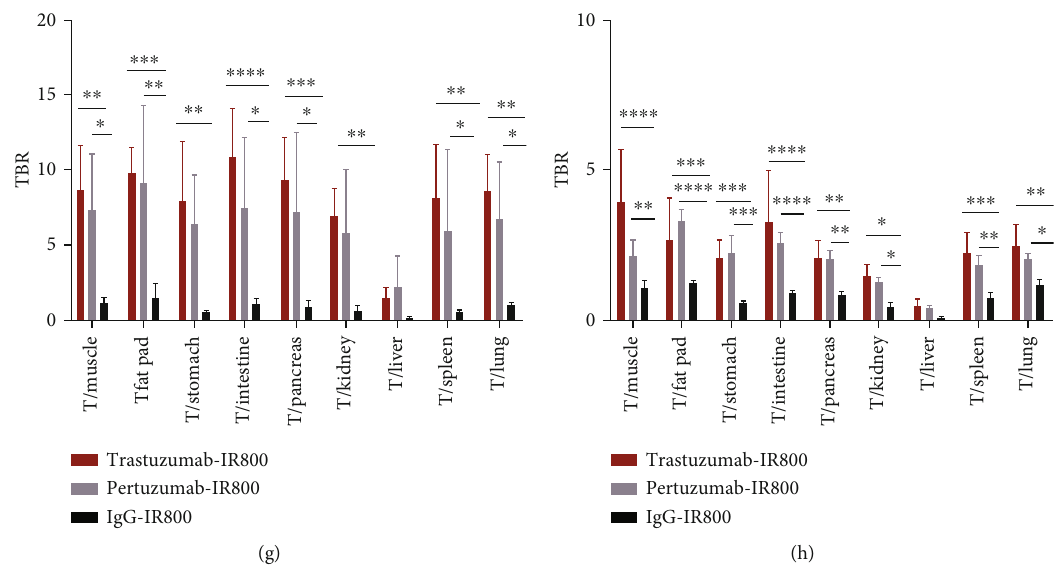
Figure 4: In vivo imaging of fl uorescently-labeled trastuzumab and pertuzumab in mouse xenografts. Representative NIRF images at 48 h p.i. in BT474 (a) and MCF7 (b) xenografts show higher uptake in HER2-overexpressing tumors. Ex vivo images from corresponding BT474 (c) and MCF7 (d) mice con fi rm tumor uptake and show minimal signal in normal tissues. Quanti fi cation of tissue fl uorescence and TBRs for BT474 (e, g) and MCF7 (f, h) mice. Data are presented as the mean ± SD . ∗ P < 0 : 05 , ∗∗ P < 0 : 01 , ∗∗∗ P < 0 : 001 , and ∗∗∗∗ P < 0 : 0001 . FAU: fl uorescent arbitrary units; TBR: tumor to background ratio. Arrow indicates the